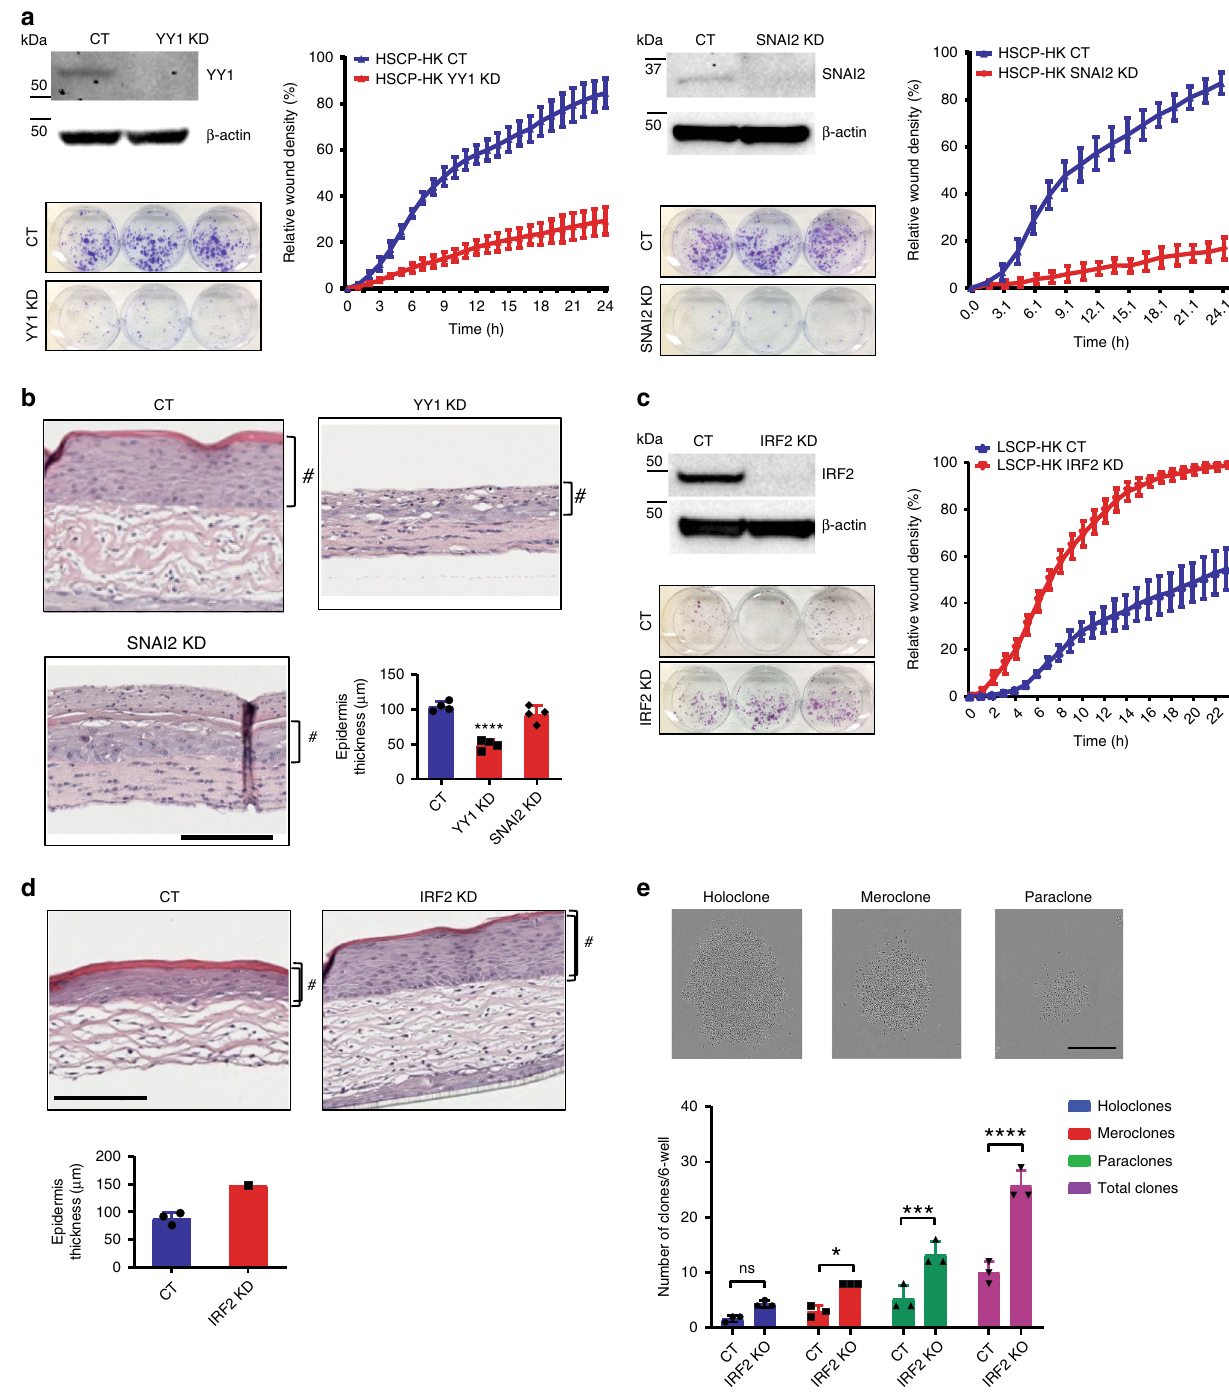
Fig. 5 Loss of IRF2 induces stem cell potential whereas loss of YY1 or SNAI2 reduces it. a Assessment of CRISPR – Cas9 mediated knockdown of YY1 (left panel) or SNAI2 (right panel) on colony formation and migration (as in Fig. 1) in HSCP-HK compared to control cells, with protein levels monitored by Western blot analysis utilizing β -actin protein level as a loading control. b Comparison of SNAI2 KD and YY1 KD to control cells in their functional ability to generate an epidermis in human dermo-epidermal 3D model. # indicates Epidermis layer. Epidermis thickness ( μ m) was quanti fi ed for each condition and differences assessed using One-way ANOVA with Holm – Š ídák multiple comparisons test. **** p < 0.0001. Scale bar = 167 μ m. Means ± S.D. of n = 4 biological replicates. c Assessment of colony formation and migration in LSCP-HK cells with CRISPR – Cas9 mediated knockdown of IRF2 compared to control cells, with protein levels monitored by Western blot analysis utilizing β -actin protein level as a loading control. d Epidermis formation in human dermo-epidermal 3D model comparing IRF2 KD cells to controls. # indicates epidermis layer. Epidermis thickness ( μ m) was quanti fi ed for each condition (means ± S.D. of n = 3 biological replicates for CT and n = 1 for IRF2 KD). Scale bar = 167 μ m. e Comparison of ability to clonally expand aHPEK-IRF2-KD versus control cells, where individual keratinocytes either fail to form a colony or form a colony belonging to three broad morphological types termed holo-, mero-, and paraclones (pictured, scale bar = 1.1 mm). Total colonies of each morphological type were counted and plotted as means ± S.D. of n = 4 biological replicates. * p < 0.05, *** p < 0.001, **** p < 0.0001 (Ordinary One-way ANOVA with Holm – Š ídák multiple comparisons